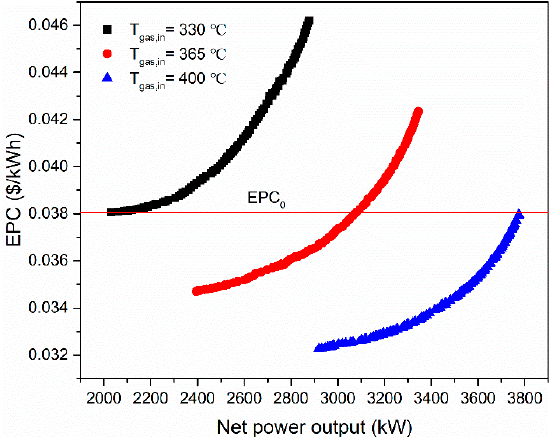
Figure 14. Pareto frontiers for the cyclo-pentane-RC system under different heat source temperatures.